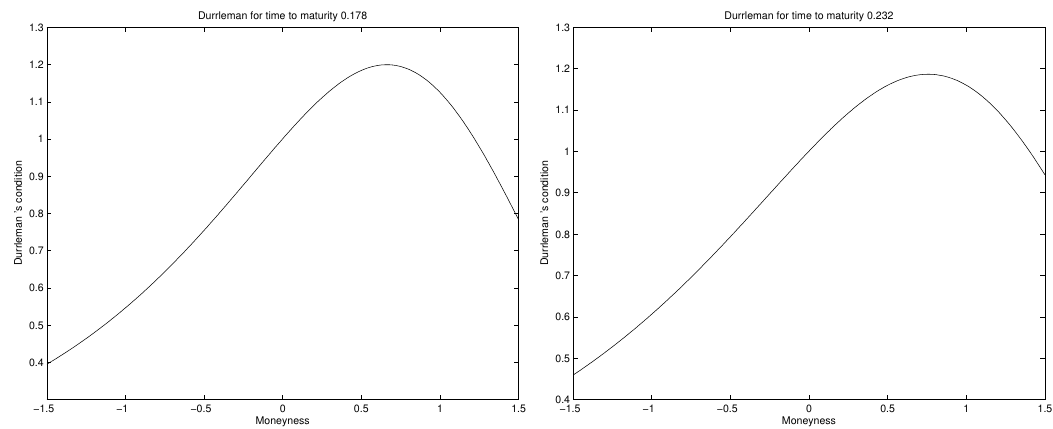
Figure 2. Plots of the Durrleman’s function implemented for six different times to